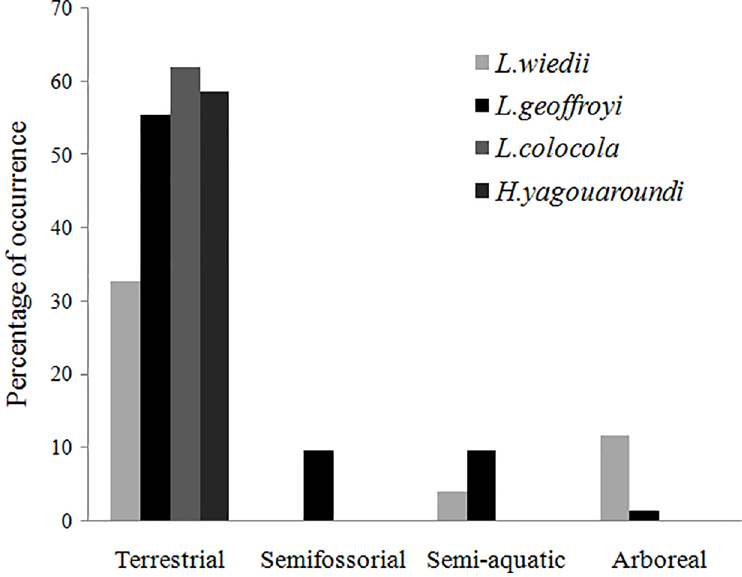
Fig 3. Primary lifestyle of mammalian prey identified in L . geoffroyi , L . wiedii , L . colocola ,and H . yagouaroundi stomach contents from Brazilian Pampa, based on the Percentage of Occurrence of prey items.